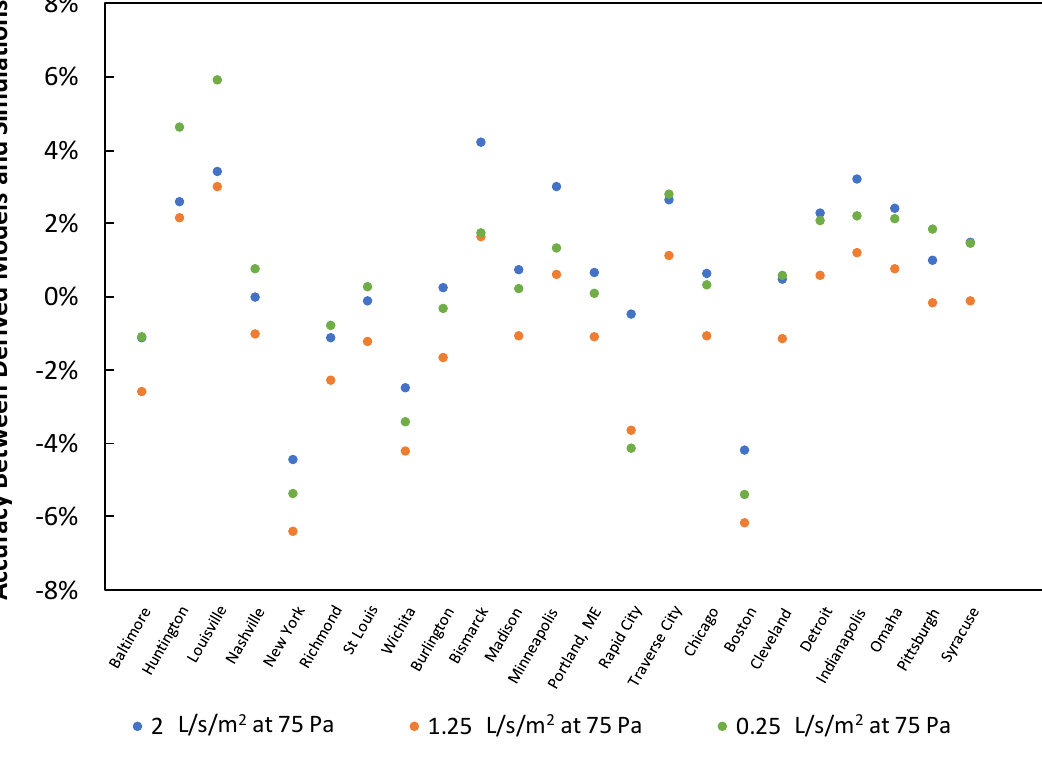
Figure 8. Differences between annual relative heating savings from the calculator and the predicted savings using the derived equation (Equation (4)) for climate zones 4A, 5A, and